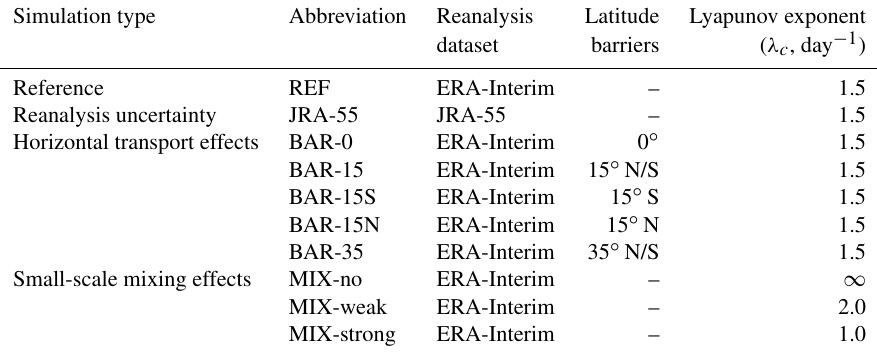
Table 1. CLaMS sensitivity simulations with respect to the used reanalysis datasets, horizontal transport barriers and small-scale mixing strengths. Note that the barriers are 10 ◦ in width with the central latitude indicated in the